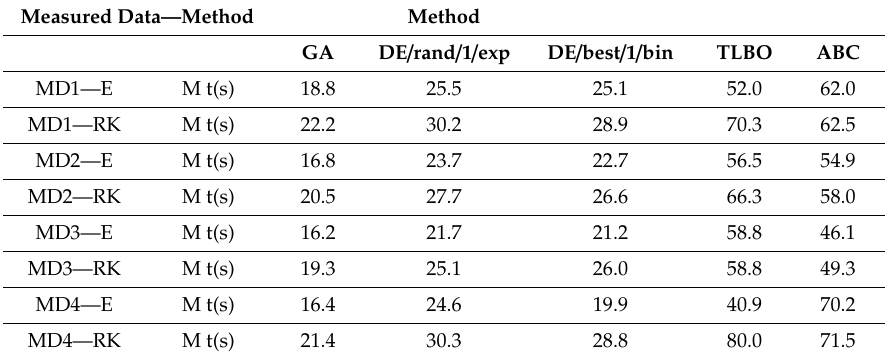
Table 19. Mean values of calculation times for 50 independent runs using EM and RK for all measured input